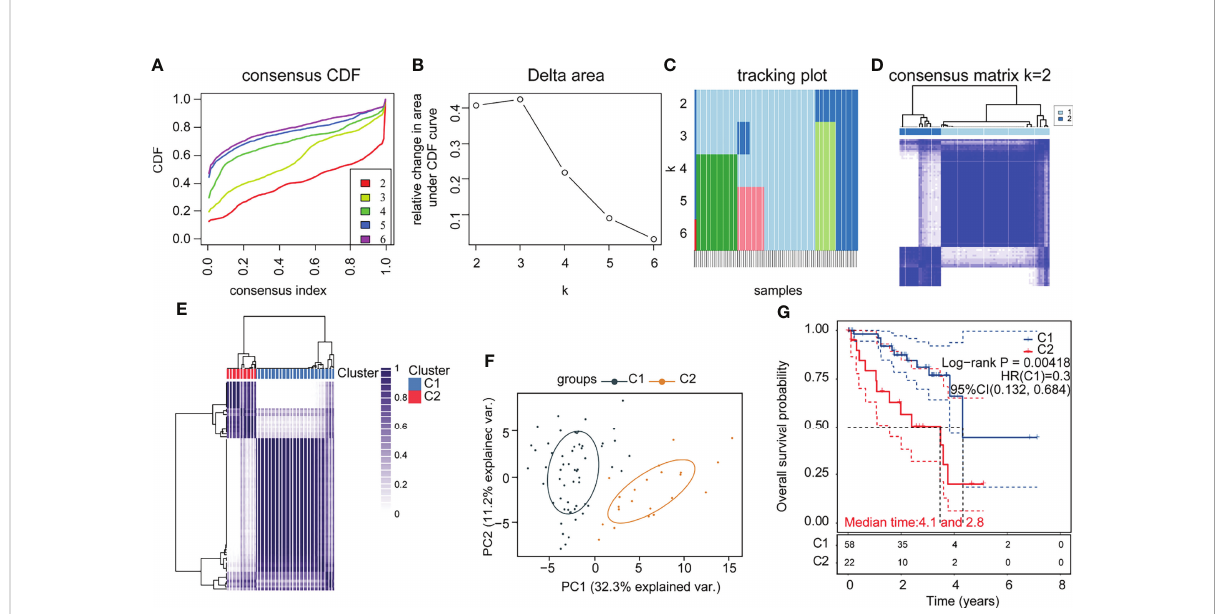
FIGURE 1 Consensus clustering of immune-related uveal melanoma (UM) (A) CDF plot; (B) CDF Delta area plot; (C) clustered sample distribution plot (the color indicates the sample distribution cohort, the vertical coordinate indicates the number of clusters, and the horizontal coordinate indicates the samples); (D) consensus matrix heat map with two sample clusters de fi ned (consensus range of 0 – 1, with 0 representing white, meaning that the samples are not clustered, and 1 representing blue, meaning that the samples are always clustered); (E) sample correlation heat map (range of 0 – 1 and the larger the value, the higher the correlation); (F) PCA (Principal Component Analysis), clustering plot between samples; (G) KM (Kaplan-Meier) survival curve of the two subgroups (statistically signi fi cant at p <